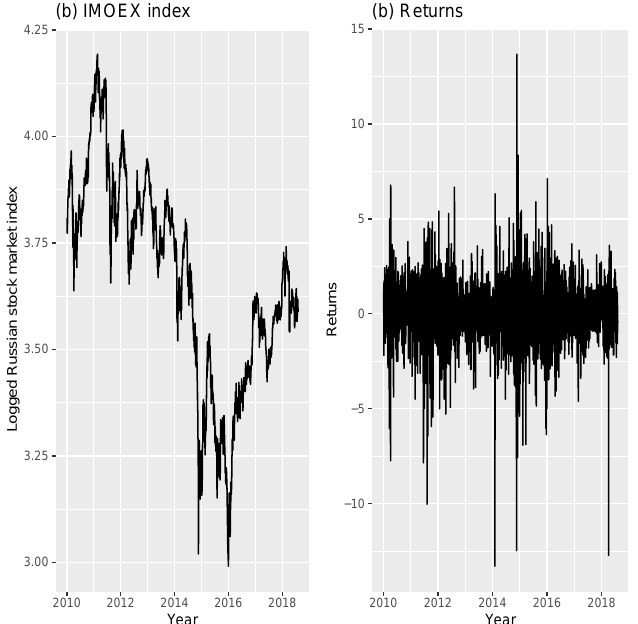
Figure 2. ( Left ) Plot of the Russian stock market index; ( Right ) Plot of the returns.